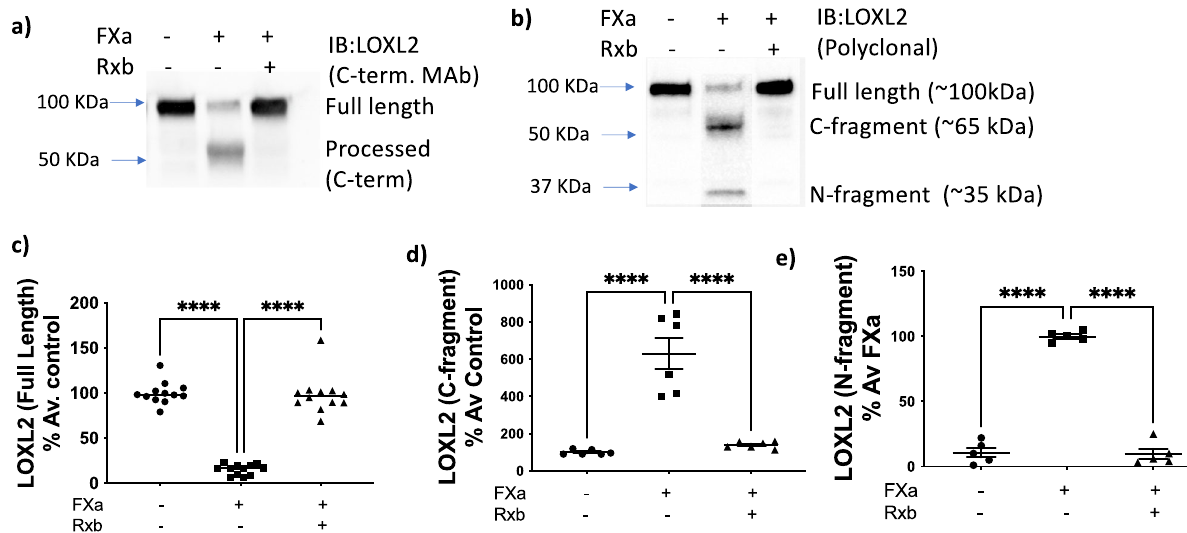
Fig. 2 Cleavage of full-length LOXL2 (~100 kDa) by FXa produces a ~65 kDa and a ~35 kDa fragment. Representative western blots and densitometry analysis of in vitro processing of overexpressed LOXL2 in the conditioned media of A7r5 cells by FXa (1 μ g/ml) in the presence and absence of rivaroxaban (Rxb, 100 nM) for 24 h. a A rabbit monoclonal antibody (Rab mAb) with epitope in the C-terminus of LOXL2 detects the full-length LOXL2 and a 65 kDa band. ( n = 6 – 12, mean ± SEM; **** P < 0.0001 by one-way ANOVA). b A polyclonal antibody targeting LOXL2 detects the full-length LOXL2 and two processed bands (65 kDa and 35 kDa). Densitometry analysis of c full-length LOXL2 (~100 kDa), d C-terminus fragment (~65 kDa), and e N-terminus fragment (~35 kDa). ( n = 5 – 6, mean ± SEM; **** P < 0.0001 by one-way ANOVA).